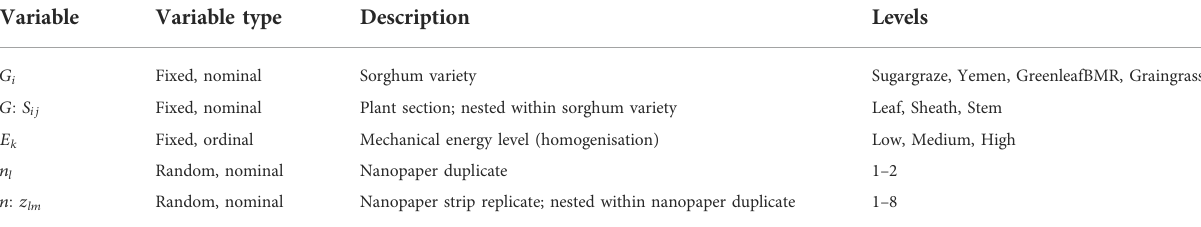
TABLE 1 Experimental factors within the Biomass-to-Nanopaper